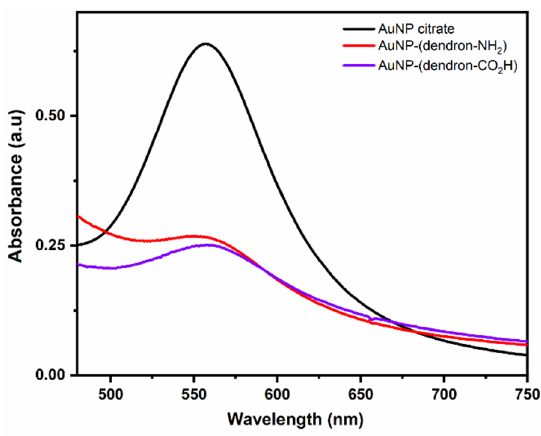
Figure 4. Absorption spectra in the visible region for all AuNPs at 100 μ M in PBS 0.1 M.